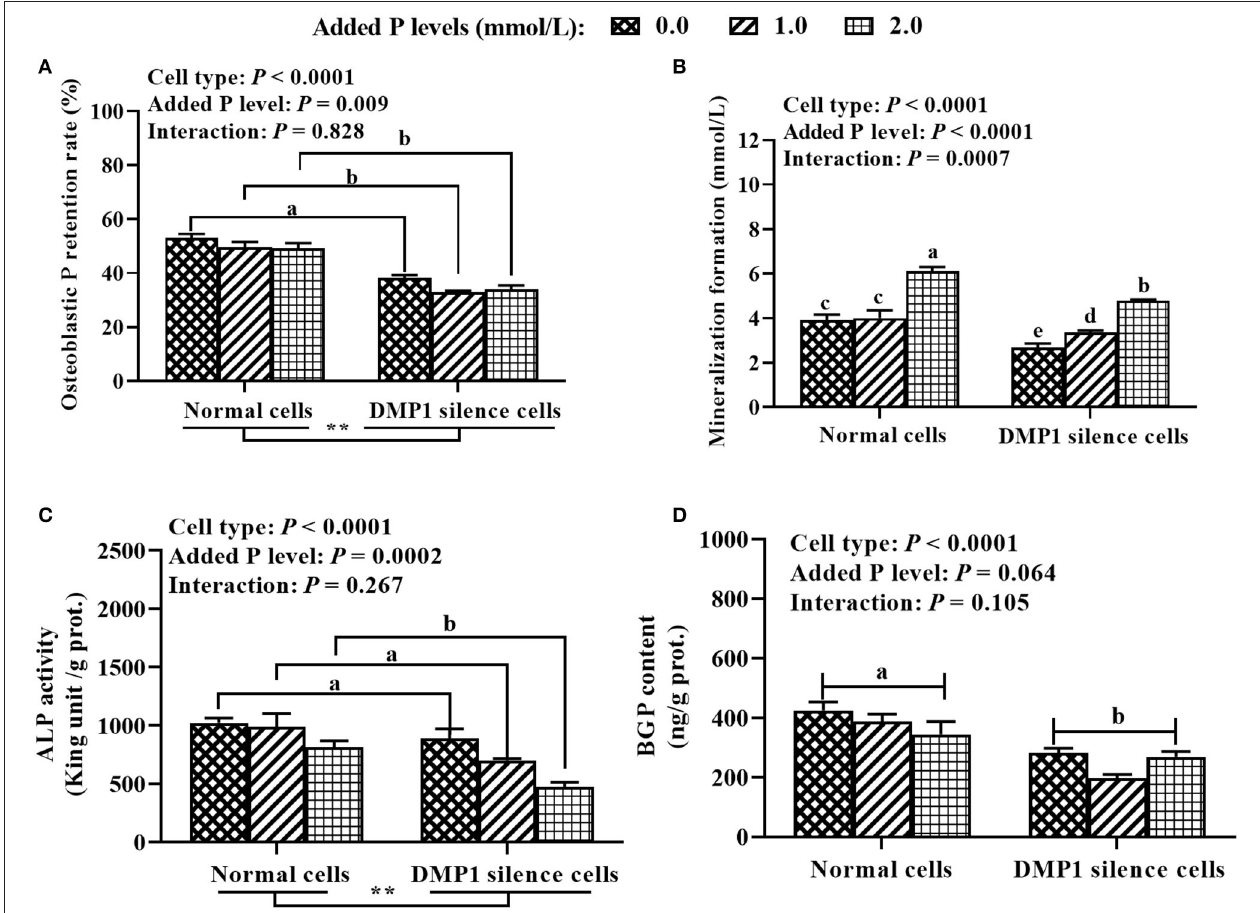
FIGURE 5 | Effect of DMP1 silencing on tibial osteoblastic P retention rate (A) , mineralization formation (B) , ALP activity (C) , and BGP content (D) in primary cultured tibial osteoblasts of broiler chicks (experiment 3). All values are expressed as means ± SE, n = 6. Means without a common letter differ, P < 0.05. ** P < 0.01. DMP1, dentin matrix protein 1; ALP, alkaline phosphatase; BGP, bone gla